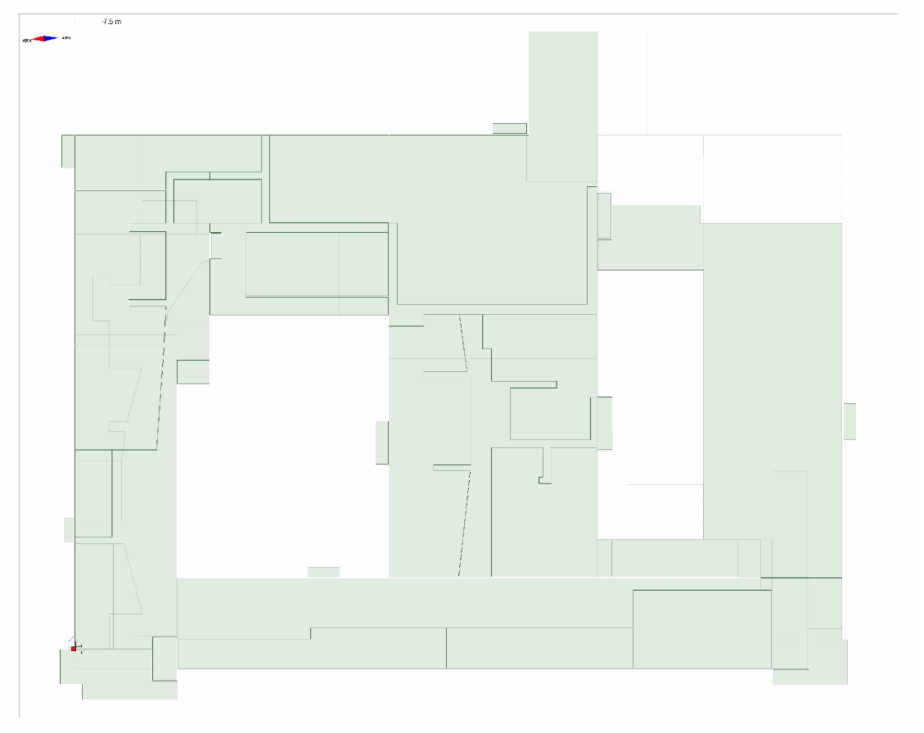
Figure A2. Second floor ( z = 4.5 m).